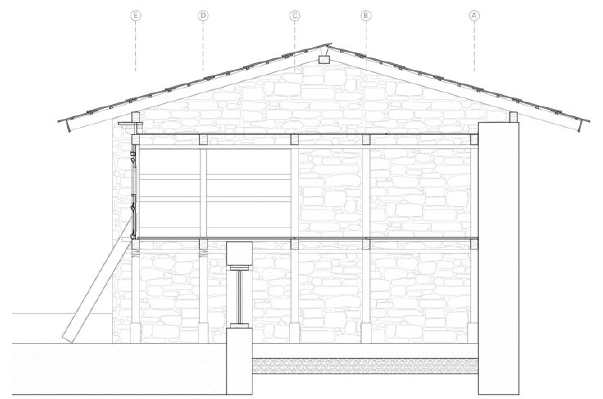
Figure 6. Interior distribution axonometric view